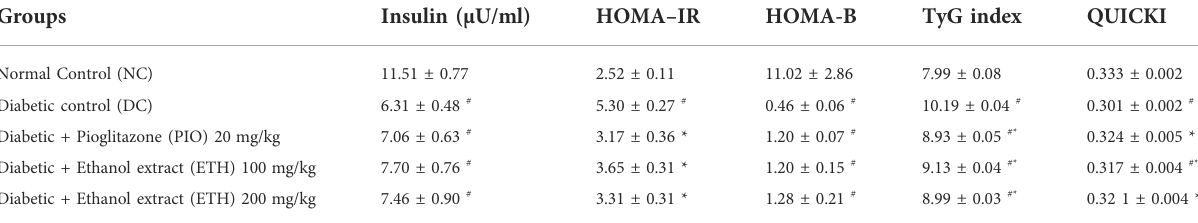
TABLE 2 Effect of MA ethanol extract on insulin resistance